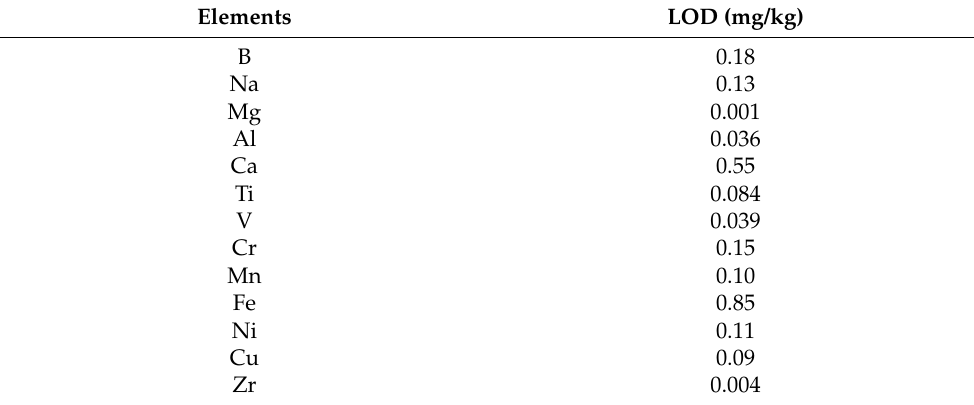
Table 2. Limit of detection estimated for the 13 selected trace elements. The LOD was estimated by using the calibration sensitivity determined using the standard reference material BAM S003a. Elements LOD (mg/kg)